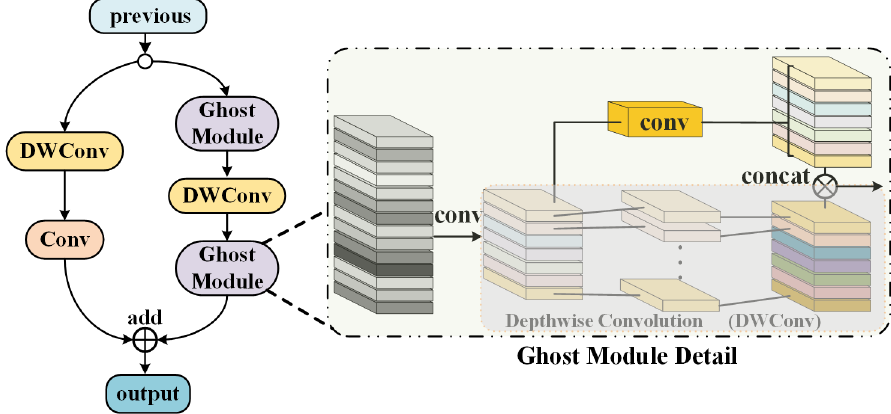
Figure 8. The structure of the Ghost-bottleneck module.